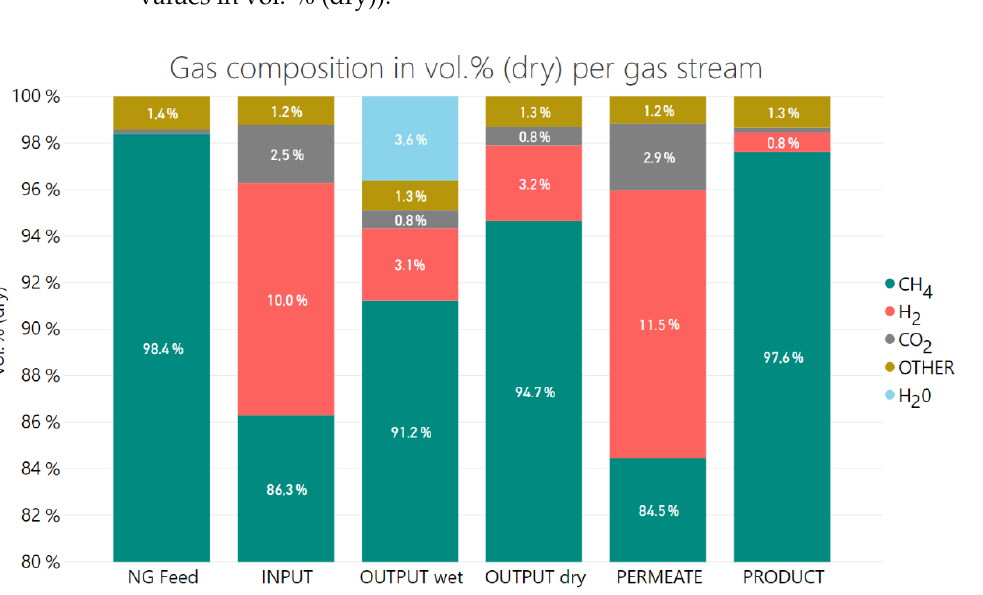
Figure 9. Gas composition per gas stream; all values in vol.-% (dry) for INPUT Case 1 (10% H 2 and 2.5% CO 2 ).